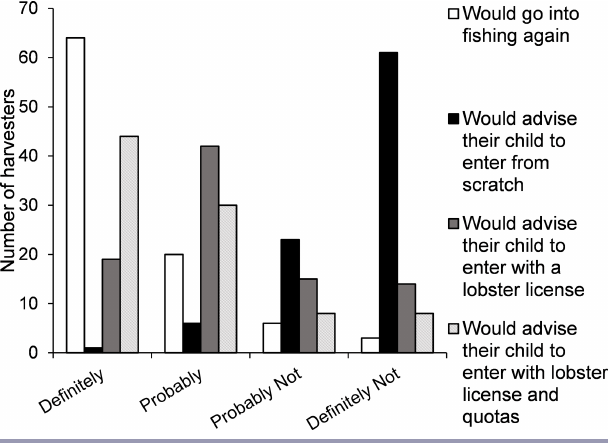
Fig. 3 . Survey responses to questions asking captains whether